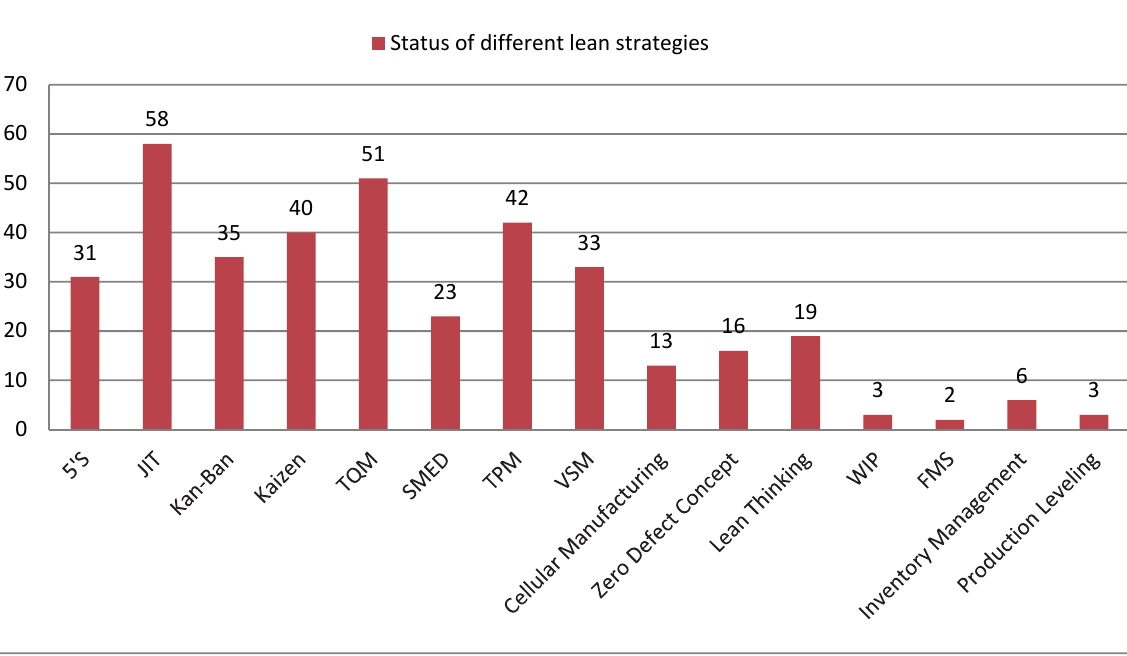
Fig. 5. Status of different lean strategies as per literature